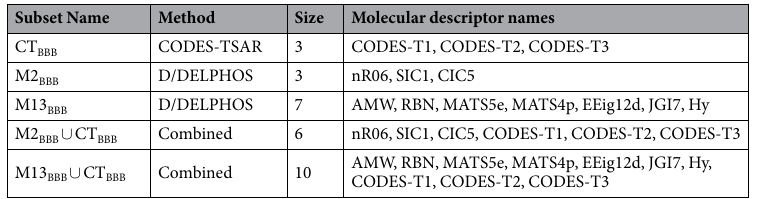
Table 2. Molecular descriptors subsets used for inferring the blood-brain-barrier QSAR